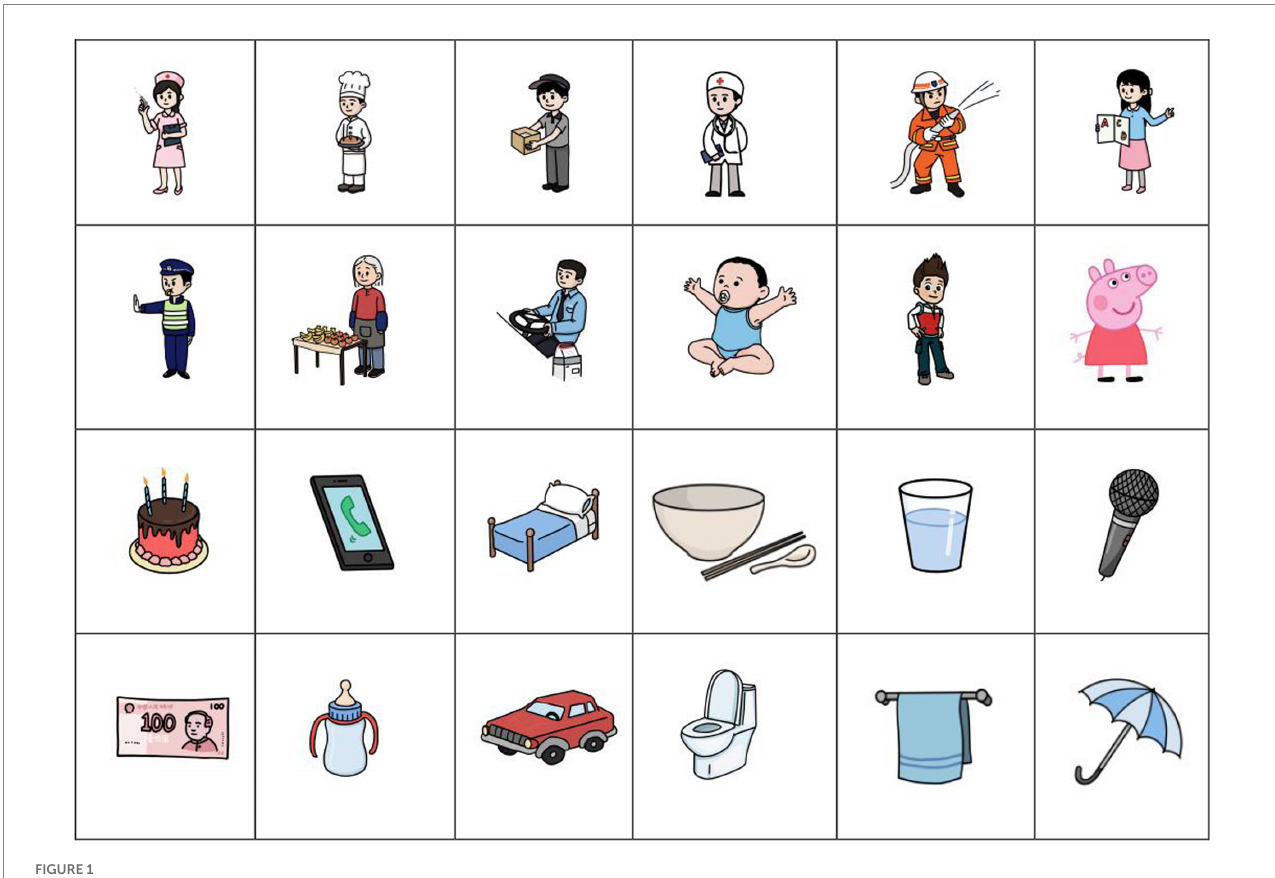
FIGURE 1 Visual